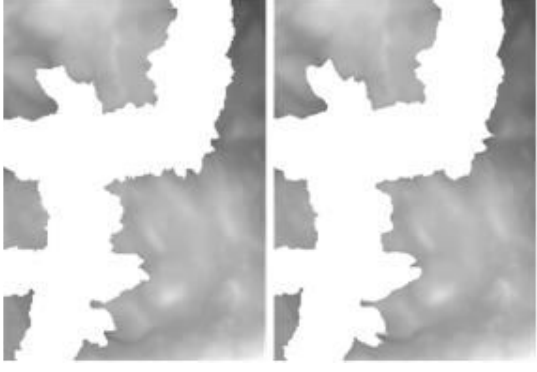
Figure 10. Results of canyon extractions performed on DTMs with the resolution of 8 (left) and 16 (right)